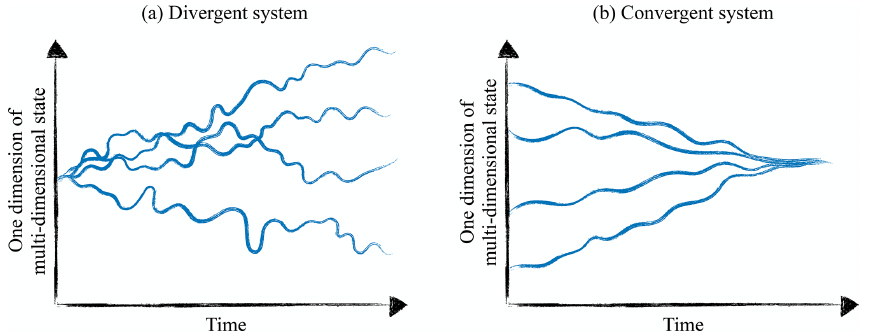
Figure 1. Dynamics of a generic divergent and convergent dynamic system with different initial states. Both panels show a single state dimension of a multi-dimensional system. In the divergent system, initially infinitesimally close states drift apart, while in the convergent system initially separate states